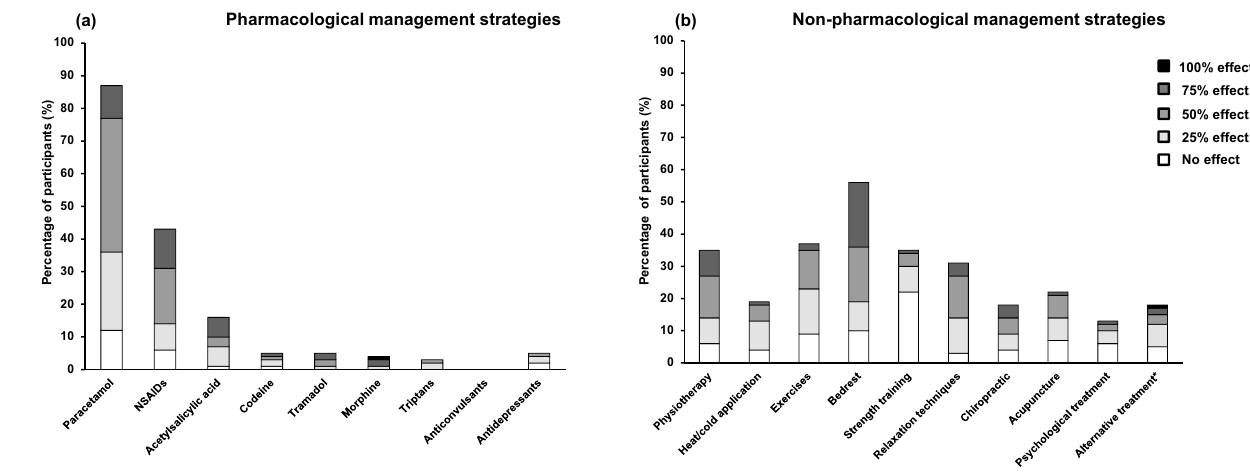
Figure 3. Management strategies to relieve persistent post-traumatic headache ( a ) pharmacological and ( b ) non-pharmacological. *The most common alternative treatment was craniosacral therapy. 25%, 50%, 75% and 100% effect indicates reported reduction in headache severity/intensity by 25% (little effect), 50% (good effect), 75% (very good effect) and 100% (headache free), respectively. NSAIDs nonsteroidal anti-inflammatory